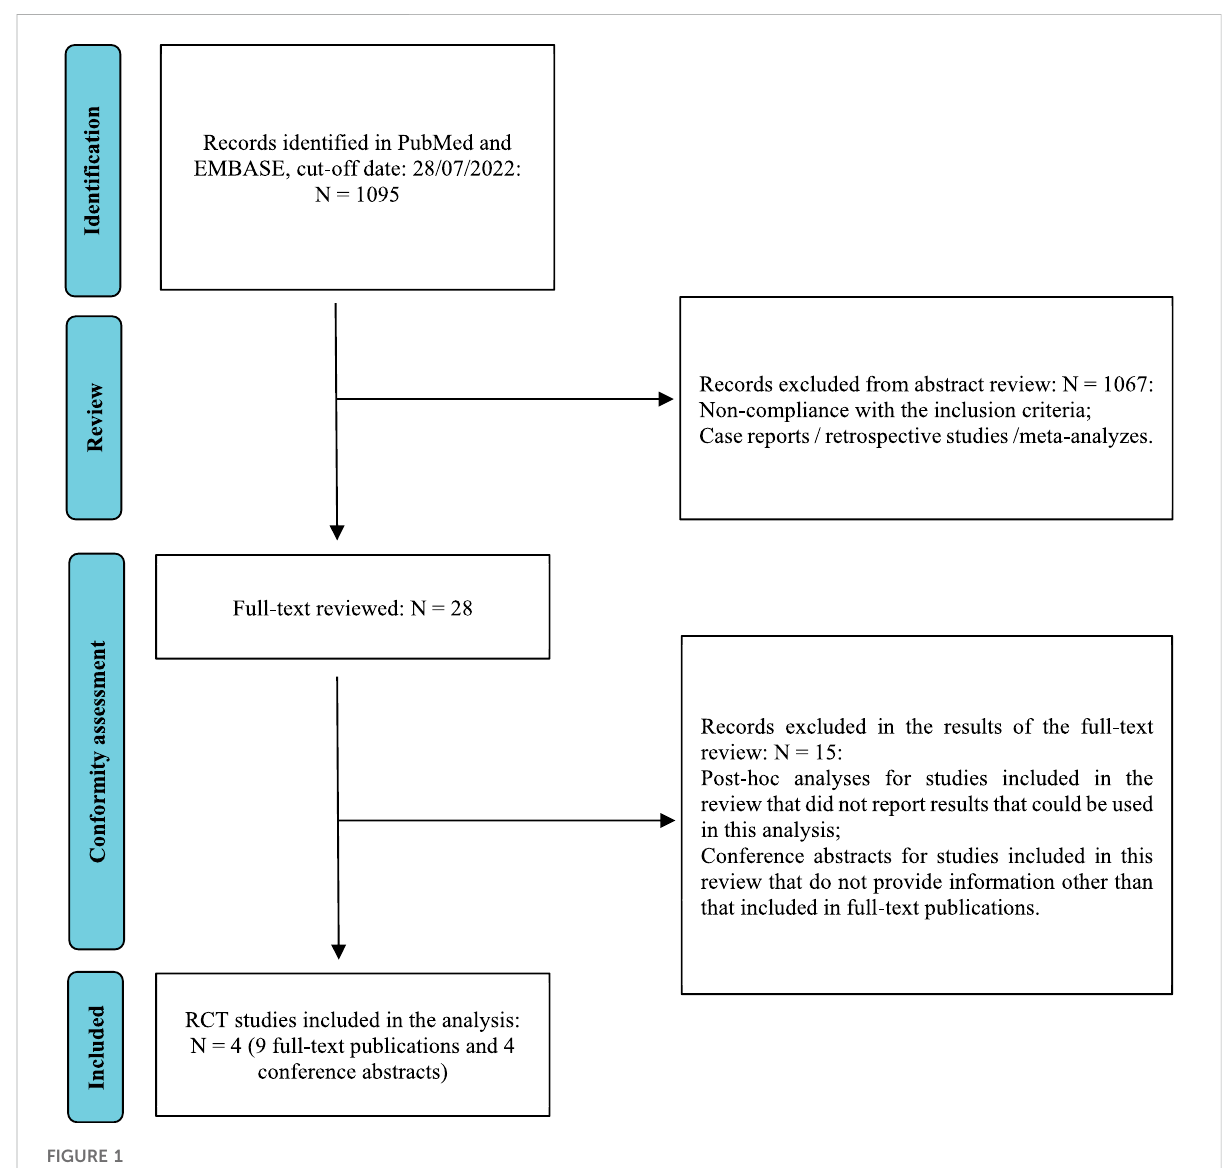
FIGURE 1 The study selection process (PRISMA) (Moher et al.,